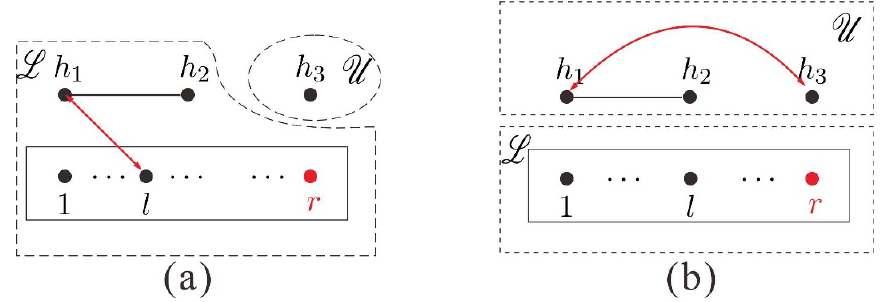
Figure 8 . Graphs (a) and (b) are the possible con(cid:12)gurations of the (cid:12)nal upper and lower blocks U , for the skeleton (cid:12)gure 6